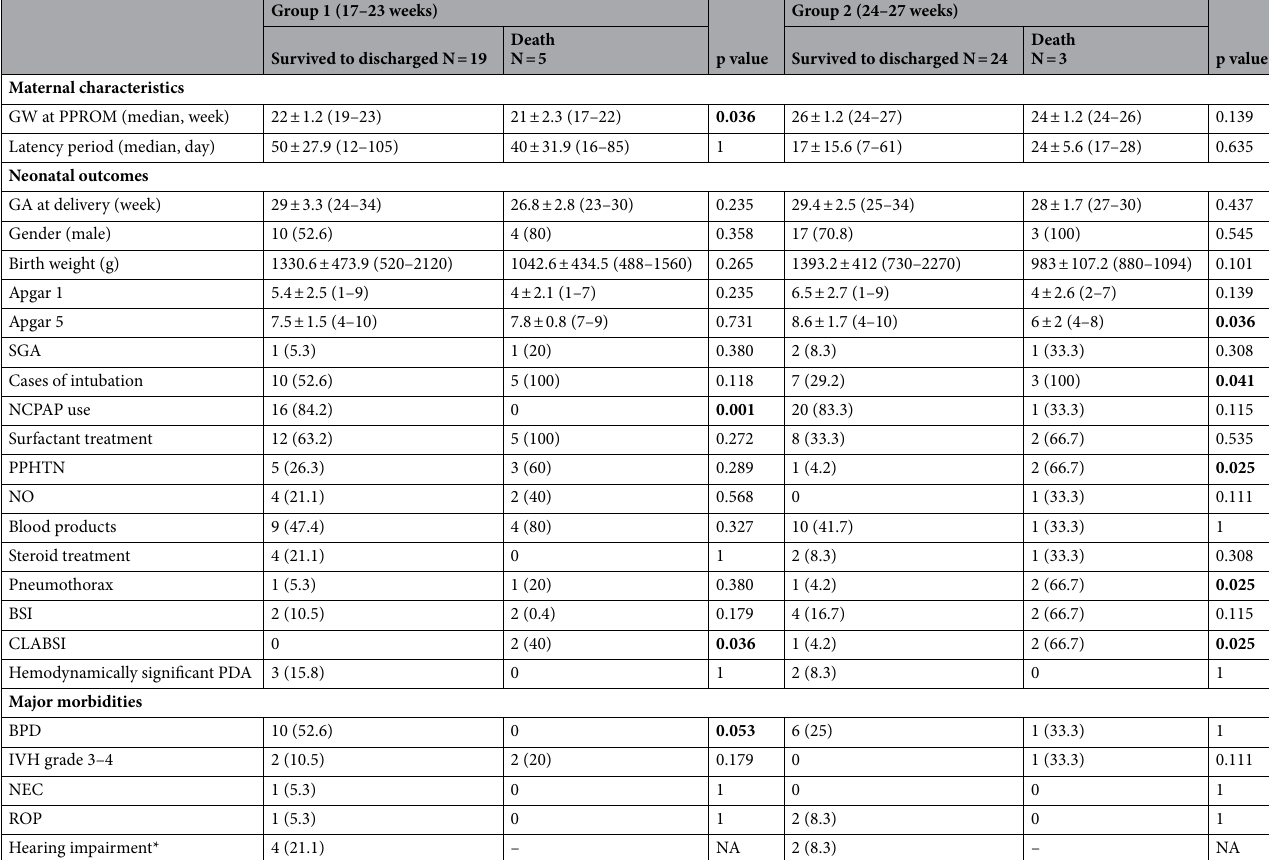
Table 3. Neonatal characteristics by survival outcome. Data are expressed as mean ± standard deviation, median ± standard deviation or n (%). GA gestational age, GW gestational week, SGA small for gestational